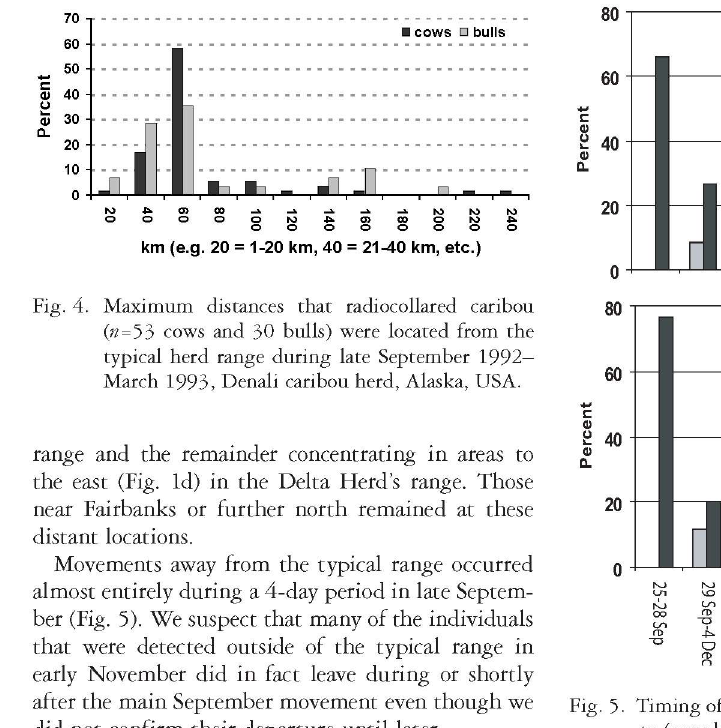
Fig. 5. Timing of departures from (black bars) and returns to (gray bars) the normal range of the Denali cari¬ bou herd, Alaska, USA, by radiocollared caribou during late September 1992—September 1993. studies during 1976—78 (Troyer, 1981) and continu ously since 1986 (Adams et al., 1995a,b; Adams & Dale, 1998). In those 21 years of telemetry studies, while some seasonal ranges have shifted, the Denali Herd has stayed within the confines of its typical range except for the events of 1992 described here. The weather patterns that preceded the September 1992 movements were equally unique. Although the climatic trigger for the unusual movements by caribou was not clear, they did remain within their typical range during the entire period of snowfall and left with the declining temperatures that followed. Their movements, along with similar movements by the adjacent Delta caribou herd, were north out of the mountains and towards lower elevations near Fair¬ banks, where only about half as much snow fell (Cole et al., 1999). Surprisingly, some caribou continued on into the mountains north of Fairbanks and spent the winter